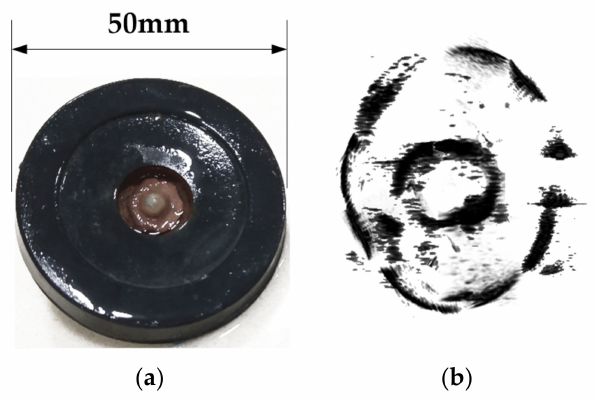
Figure 25. Reconstructed image of the real target with the PSM: ( a ) The real target; ( b ) The reconstructed image.